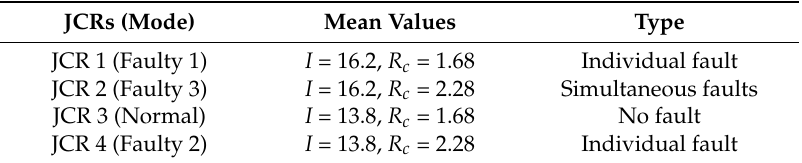
Table A1. Faults Definition and Description.